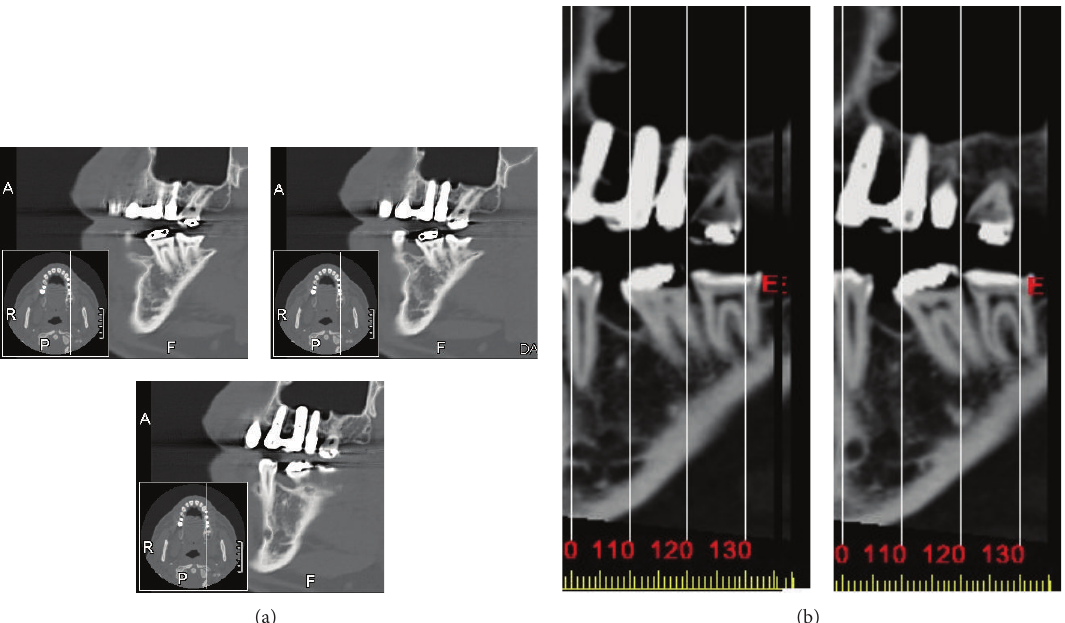
Figure 7: (a) CT scans showed the implant and surrounding bone and the new sinus floor using the staged osteotome sinus floor elevation technique on the left side 2 years after the operation. (b) Selected magnifying images for CT scans showed the implant, apical borders for these implants, surrounding bone, and the new sinus floor using the staged osteotome sinus floor elevation technique on the left side 2 years after the